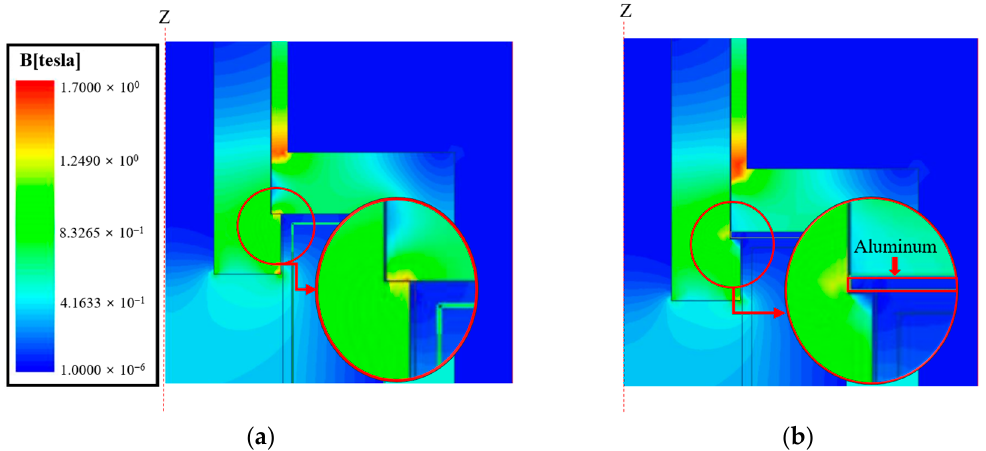
Figure 10. The magnetic flux density of the current applied in the open state ( a ) without and ( b ) with a gap.